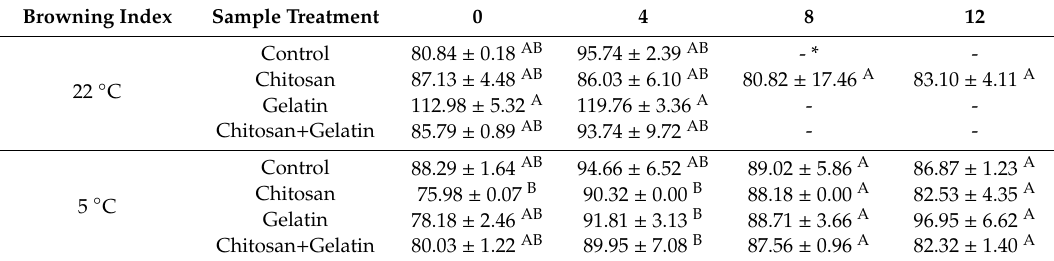
Table 2. Browning index of cut apple cubes coated with di ff erent coatings and stored at 5 ◦ C and 22 ◦ C for 12